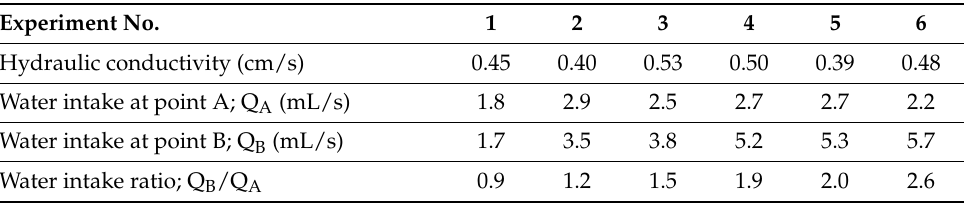
Table 1. Experimental parameters. Hydraulic conductivities, pumping rates at Wells A and B, and pumping